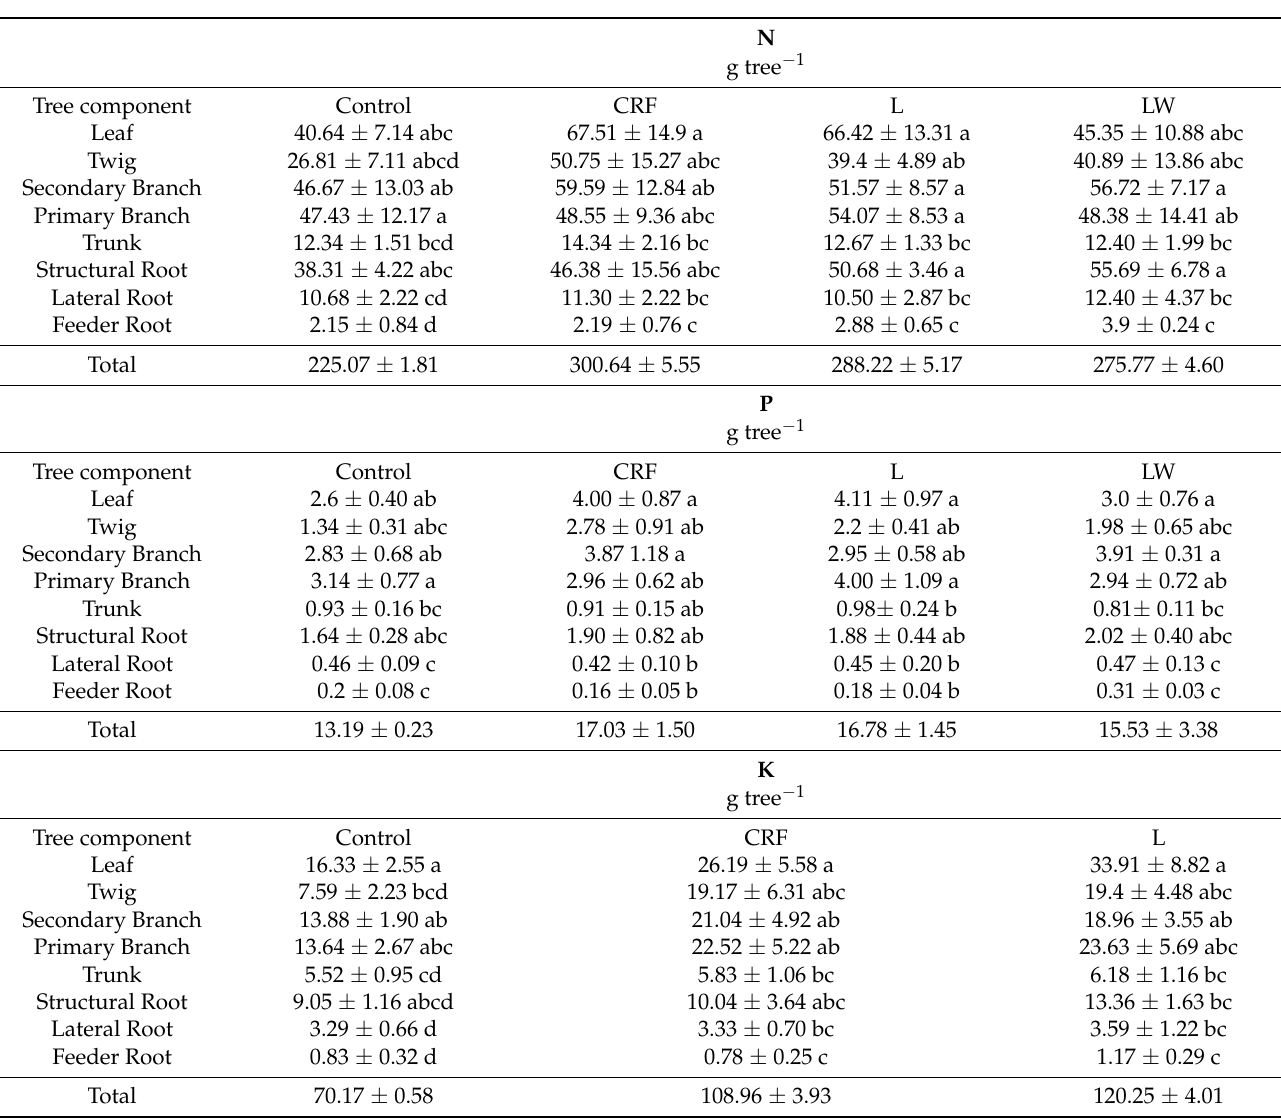
Table 1. Nitrogen (N), phosphorus (P), and potassium (K) contents per individual tree components and tree total. Six-year-old Huanglongbing -affected ‘Ruby Red’ grapefruit trees grafted on sour orange rootstock were used. Treatments consisted of two liquid (L and LW) and two granular fertiliz- ers (Control and controlled-release fertilizer (CRF)). A Kruskal–Wallis test was used in combination with a Tukey’s honestly significant difference (HSD) test to identify and test significant differences in total nutrients in individual tree components (differences signified by letters). Data represents means ( n = 4) ± standard